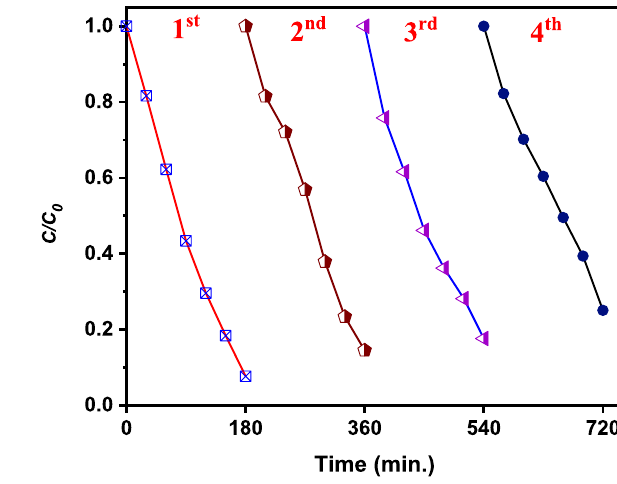
Fig. 11 Four repeated processes of 4% Y-doped SnO degradation of MB under UV–visible light